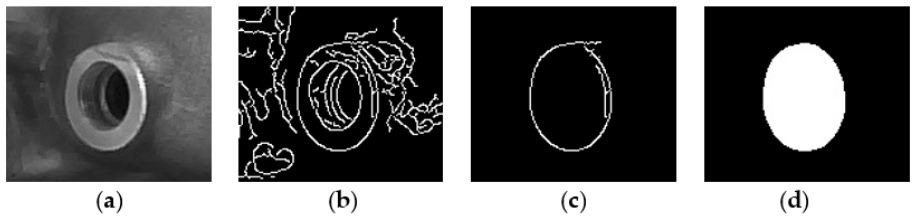
Figure 3. Outputs of the proposed image segmentation procedure on the sensor boss: ( a ) image conversion, ( b ) ROI filtering; ( c ) contour selection; ( d ) morphological filtering.